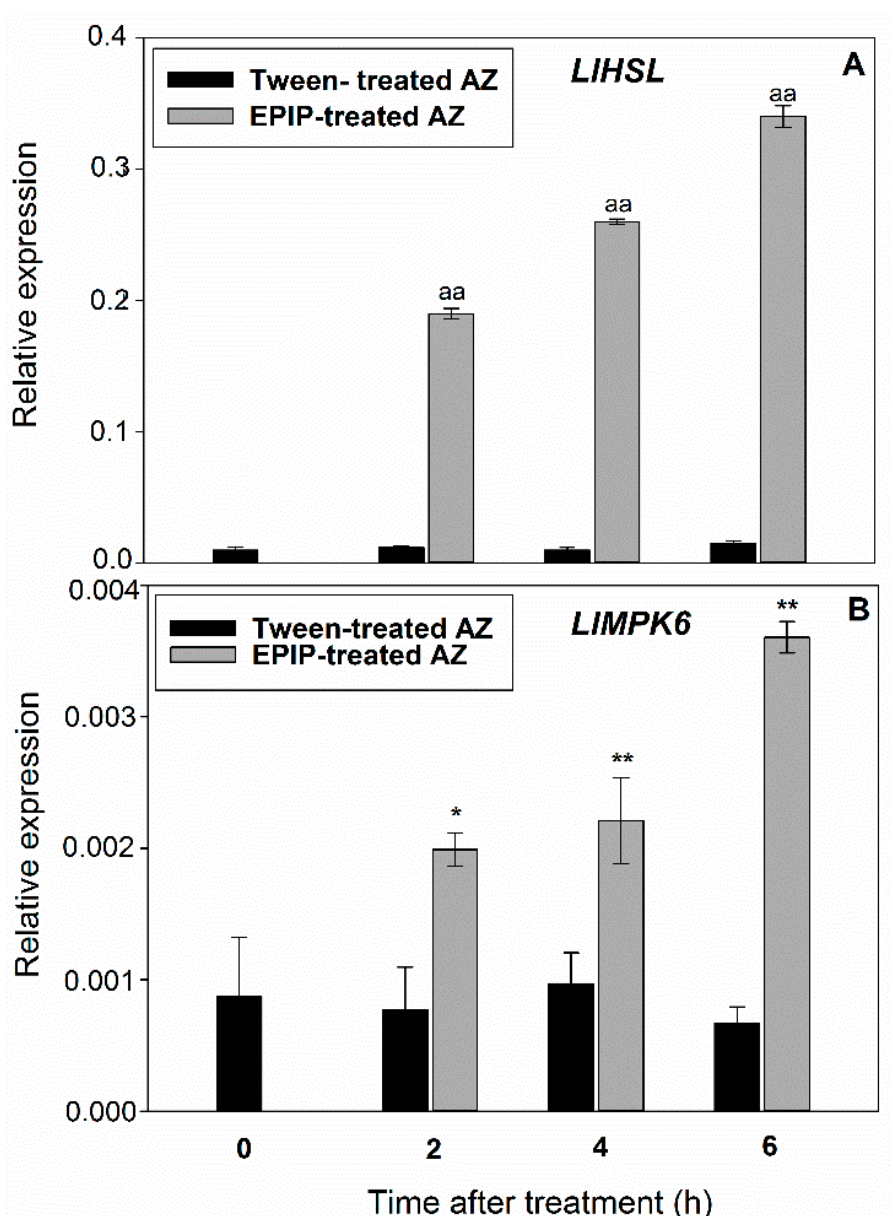
Figure 1. Exogenous EPIP affects molecular elements of the abscission-related signaling pathway in the floral abscission zone (AZ) of yellow lupine. Transcriptional activity of LlHSL ( A ), and LlMPK6 ( B ) (related to LlACT ) in AZ after EPIP treatment. Fragments of AZ were excised at 2 h, 4 h, and 6 h after EPIP (100 µM) solution in 0.05% Tween 20 applied directly on inactive AZ. The control was inactive AZ dissected at the same time variants from the flower bases after the application of the 0.05% Tween 20 solution. Data are presented as averages ± SE. For LlHSL , significant differences for EPIP treated plants in comparison to control are indicated as aa p < 0.01; for LlMPK6 , significant differences for EPIP treated plants in comparison to control are indicated as ** p < 0.05, * p < 0.01.